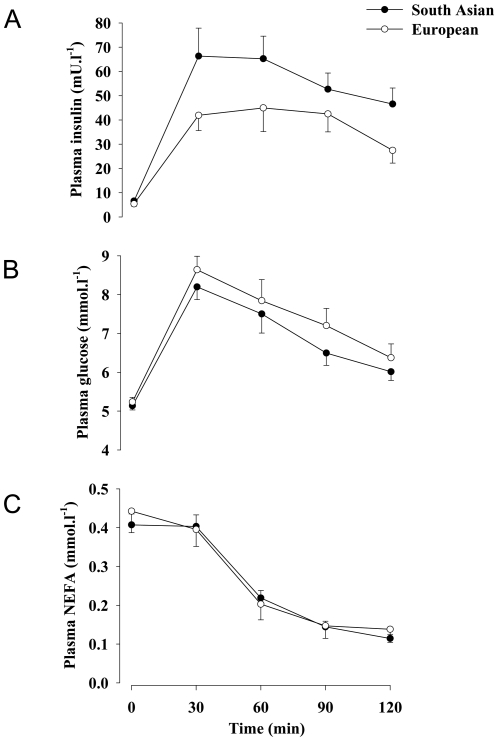
Plasma insulin (A), glucose (B) and NEFA (C) responses to a 75 g oral glucose load.Summary measures of these responses are presented in Table 3.